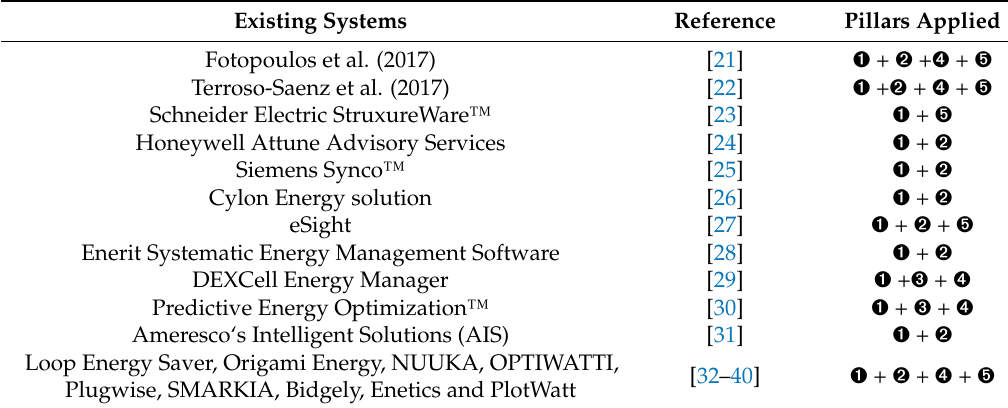
Table 2 recaps the abovementioned systems, pointing out the types of input data applied. Table 2. Existing systems and pillars applied.